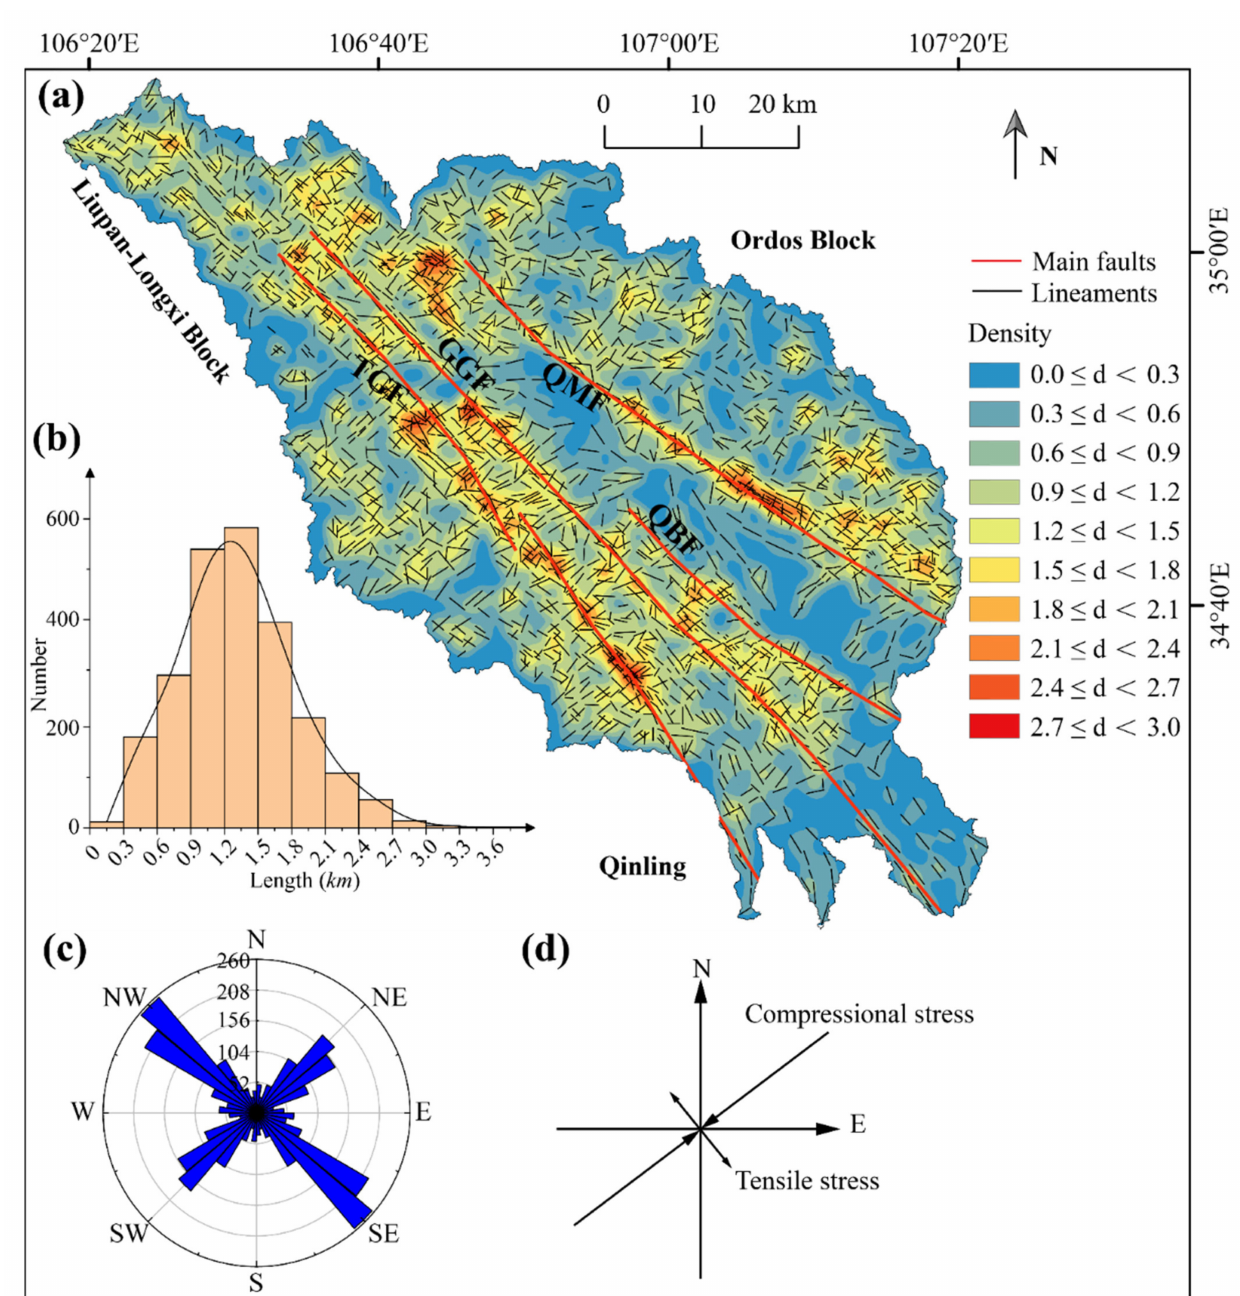
Figure 4. Distribution of lineaments in the Qianhe Graben. ( a – c ) are the density, length, and azimuth distribution maps of the lineaments in the Qianhe Graben, respectively. ( d ) is the vector map of the principal strain rates of the Qianhe region (unit: 10 − 8 /year), collected from